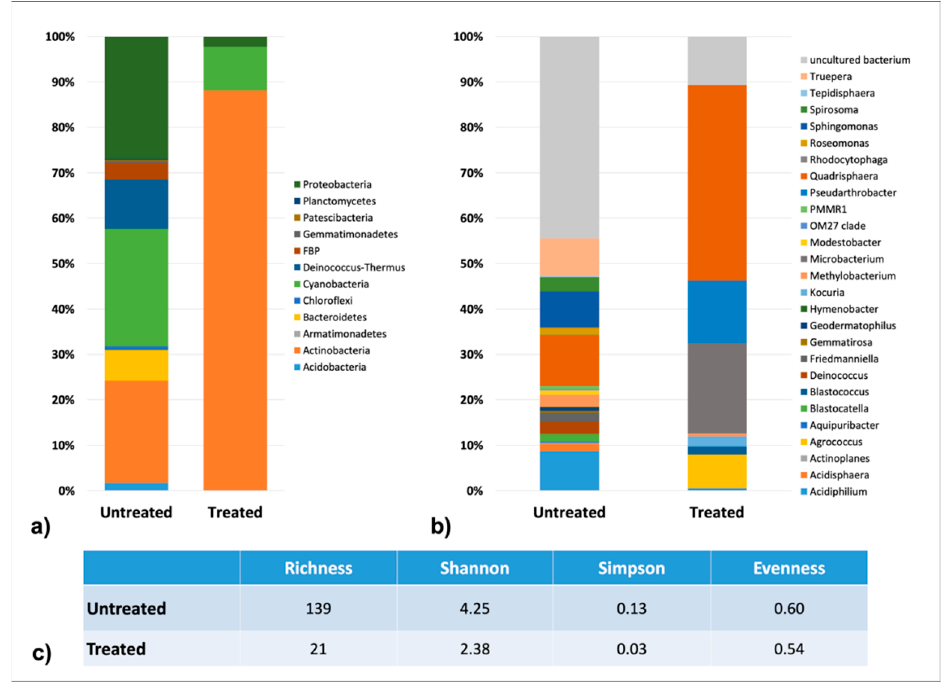
Figure 7. Bacterial community composition on untreated and treated surfaces at phylum (panel a ) and genus (panel b ) levels. Alpha-diversity indexes of the taxonomic profiles at the 97%-similarity threshold (panel c ).